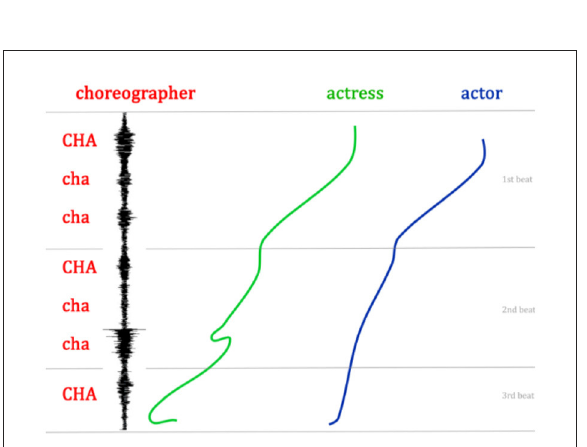
FIGURE4.2 ACM regains synchrony.